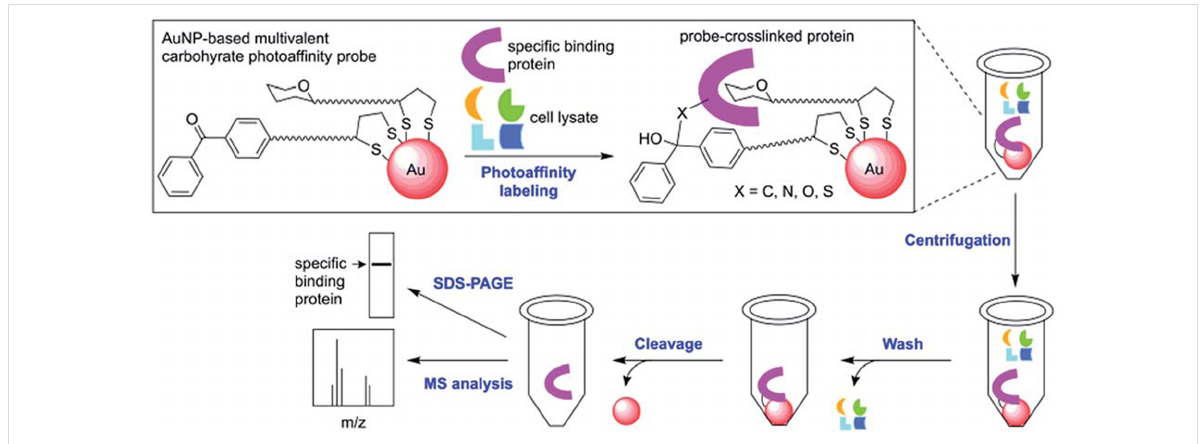
Figure 5: A photoaffinity labeling (PAL) approach based on glyco-gold nanoparticles is able to recognize and isolate only the desired protein. After washing and cleavage steps, the protein can be fully analyzed. Reprinted from [81]. Published by The Royal Society of Chemistry.